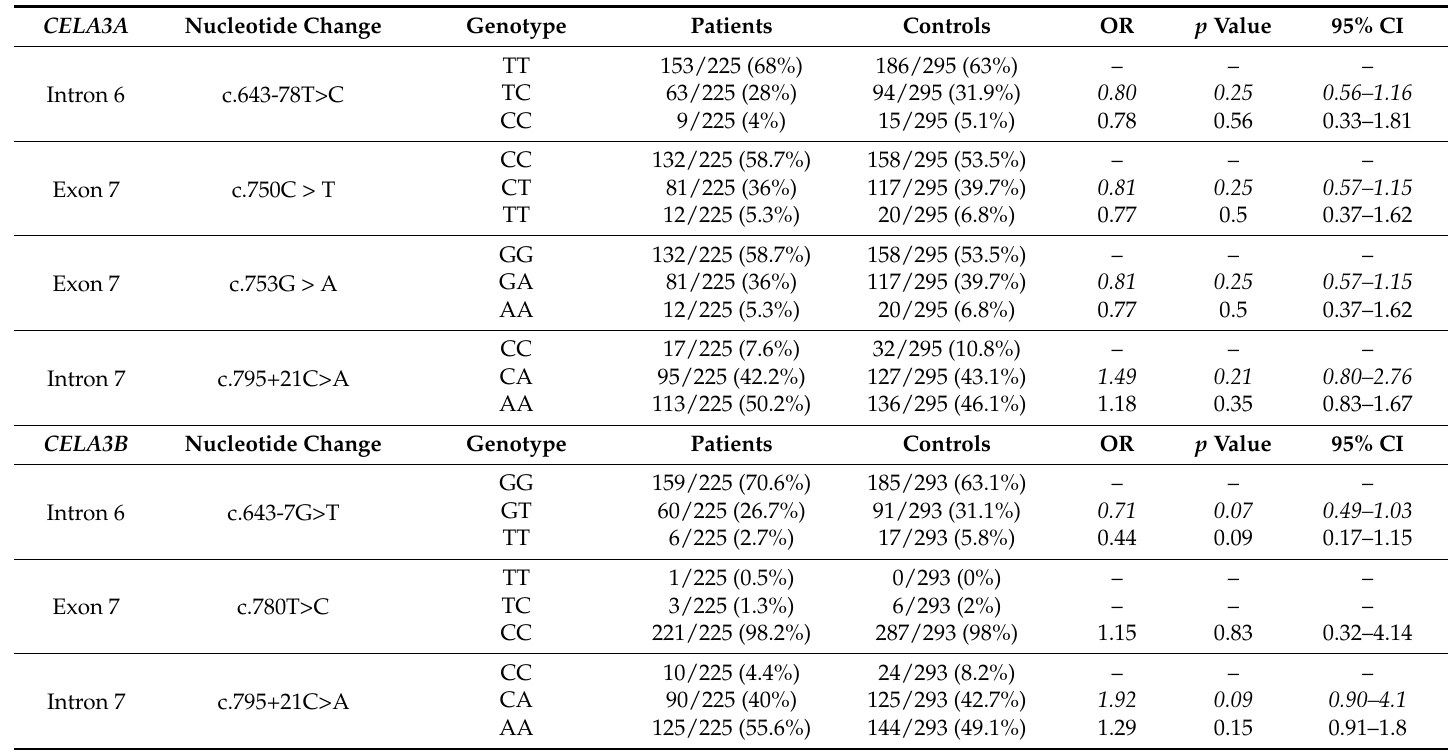
Table 4. Genotype distribution of common CELA3A and CELA3B variants. Results were analyzed assuming dominant (shown in italics) or recessive models of inheritance. OR, odds ratio; CI, confidence